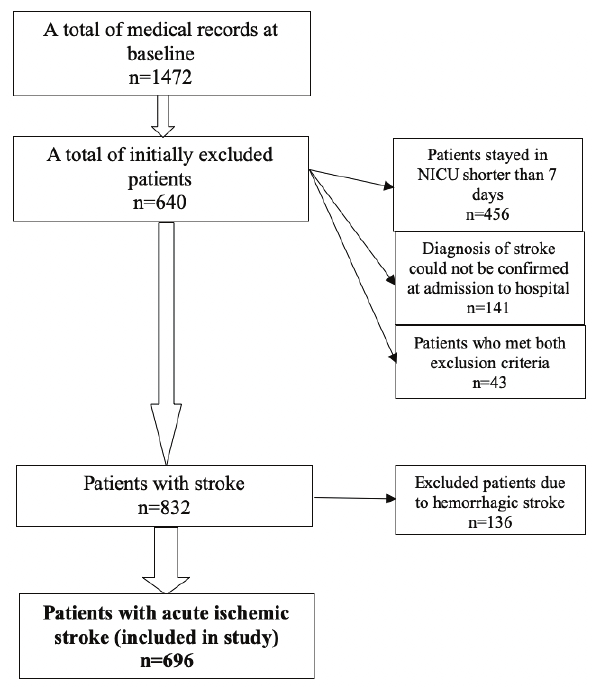
Figure 1: Patients´ selection